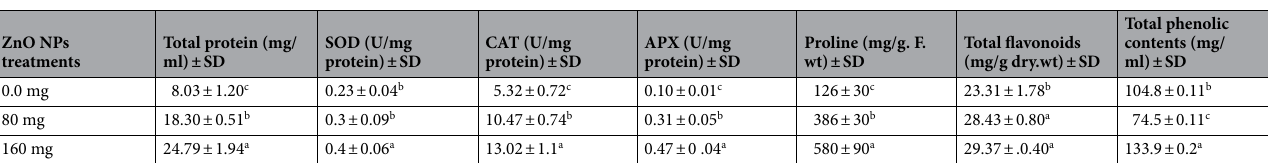
Table 1. Effect of ZnO NPs on total protein, enzymes activity, proline, flavonoids and total phenolic contents of J. procera. The data are presented the average of total protein, enzymes activity, proline, total flavonoids and total phenolic contents ± standard deviation (SD). a,b,c Means within the same column with different superscripts differ significantly ( P < 0.05